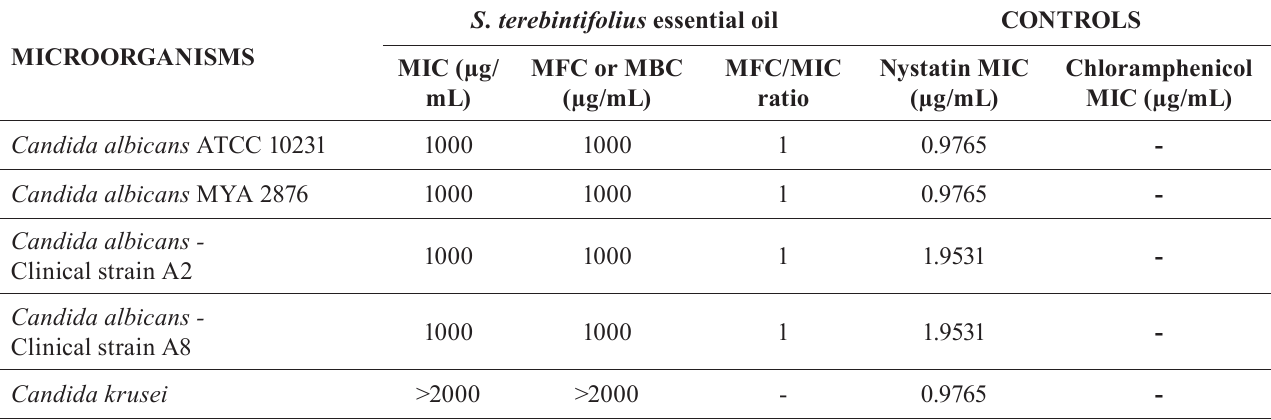
TABLE I - M inimum Inhibitory Concentration (MIC), Minimum Fungicidal (MFC) and Minimum Bactericidal (MBC) concentrations of the S. terebinthifolia green fruits EO, according to different microbial